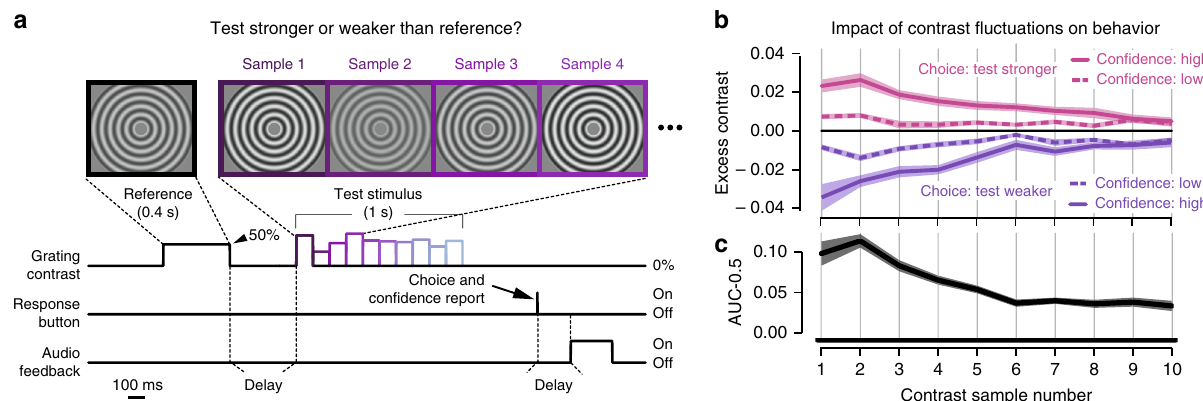
Fig. 1 Behavioral task and temporal accumulation of sensory input for decision-making. a Schematic of task events during example trial. Each trial started with a reference stimulus, a circular moving (expanding or contracting) grating with constant contrast (50% in all trials), followed (1 – 1.5 s delay) by a test stimulus. The test was another circular moving grating made up of ten consecutive samples of fl uctuating contrast. Sample contrasts were drawn from a normal distribution ( “ Methods ” ). The task was to indicate if the mean test contrast (averaged across samples) was stronger or weaker than the reference contrast. Auditory feedback (low or high tone) was provided after another variable delay (0 – 1.5 s). Gratings depicted here have lower spatial frequency than in the experiment for visualization purposes. b Impact of contrast fl uctuations on behavior. Top, contrast fl uctuations around the sample mean (i.e., expected contrast on sample s ) sorted by behavioral response (choice and con fi dence judgment). Bottom, psychophysical kernel quantifying impact of trial-by-trial contrast fl uctuations on choice, as a function of sample position, expressed as deviation of area under the ROC curve from chance level (AUC = 0.5, see “ Methods ” ). Data are represented as mean ( n = 15 subjects, lines) and ±SEM (shaded areas). Black horizontal bar, p < 0.05 (FDR- corrected two-sided t -test of AUC different from 0.5). Source data are provided as a Source Data fi